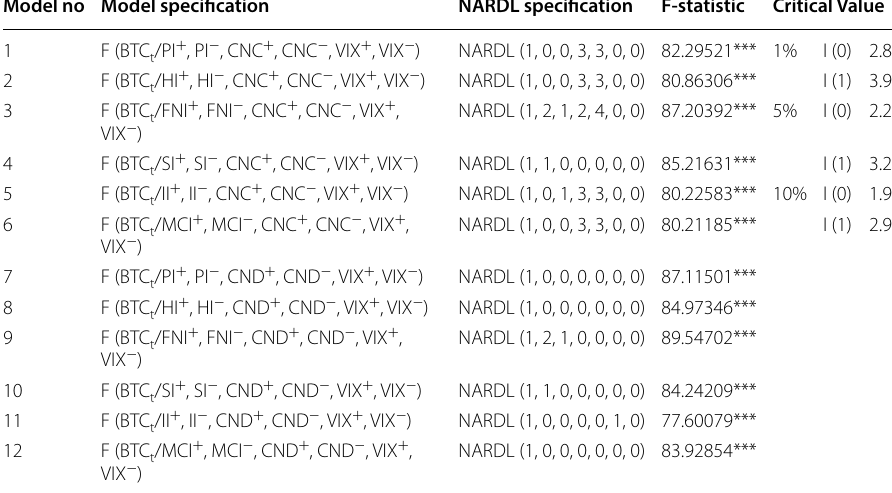
Table 7 Bounds test for nonlinear